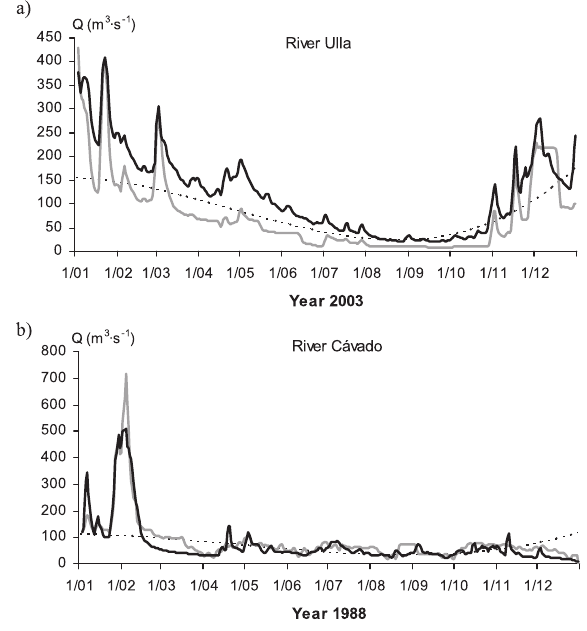
Fig . 5. – Reconstructions of the river discharge signal for the River Ulla (a) and River Cávado (b). The real data (solid gray line) and the climatological signal (dashed black line) are compared to the reconstructed signal (solid black line).